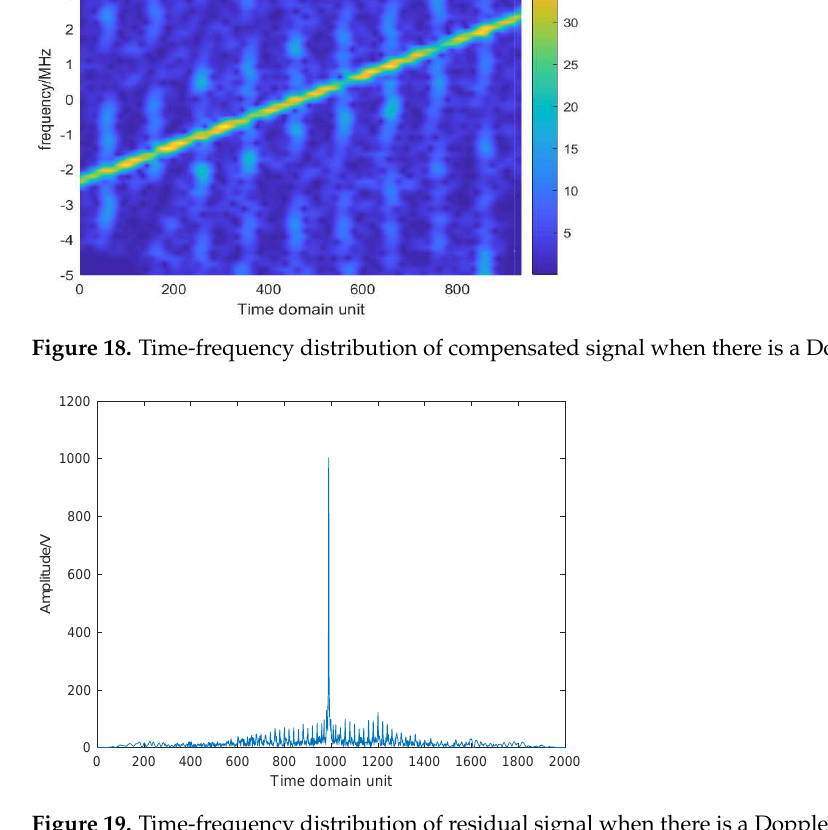
Figure 19. Time-frequency distribution of residual signal when there is a Doppler